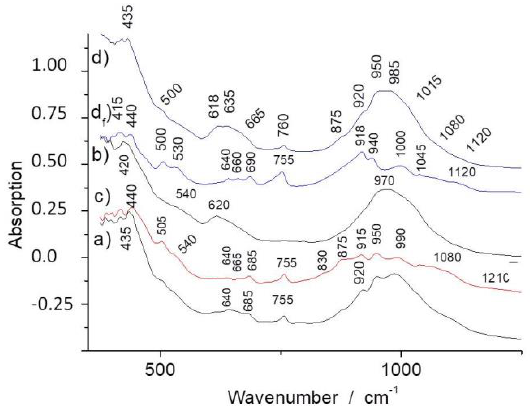
Figure 2. SEM micrographs showing asbestos fiber clusters in broken sections of samples ( a , b , d ) (see Figure 1); ( a ) large fiber pull-out after fracture; ( b’ ) detail of the sliced section of sample ( b ) showing the fiber bundles.